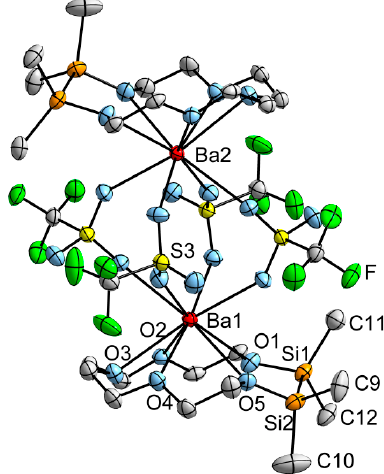
Figure 5. Molecular structure of [Ba(1,2disila[15]crown-5)OTf 2 ] 2 ( 5 ) in the crystal. Thermal ellipsoids represent the 50% probability level. Hydrogen atoms are not displayed. Selected bond lengths (pm)